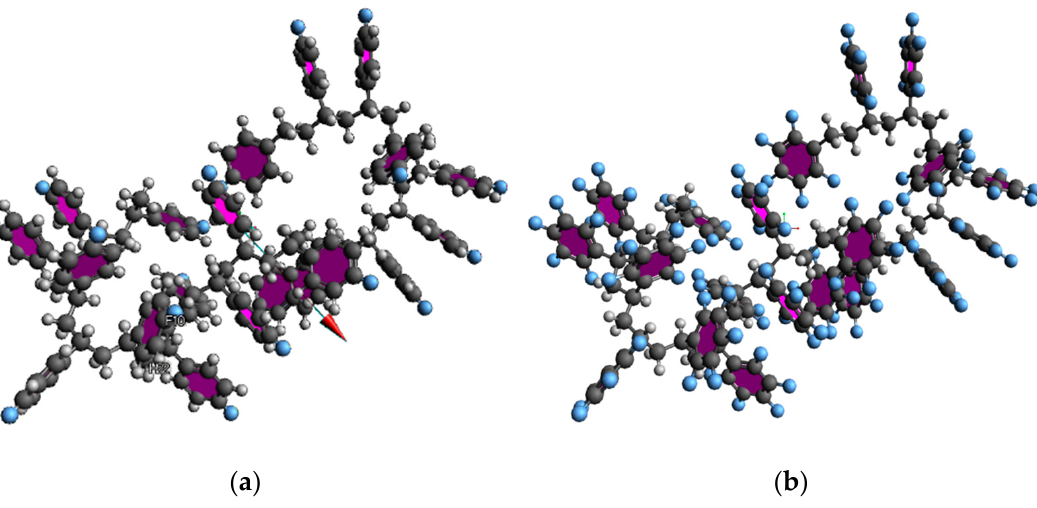
Figure 3. Fluorinated polystyrene: ( a ) 1F-PS(poly(4-fluorostyrene)) ( b ) 5F-PS(poly(2,3,4,5,6-pen-tafluorostyrene)).